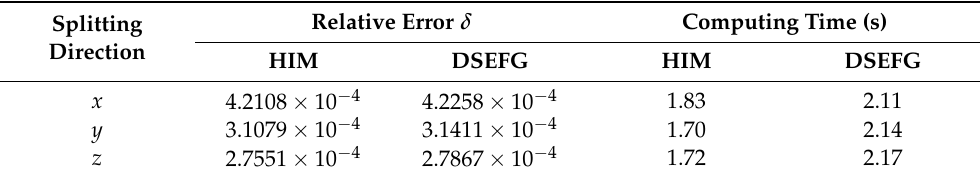
Table 5. Comparison of relative error and computing time under splitting directions x , y and z given by the DSEFG method and HIM method.